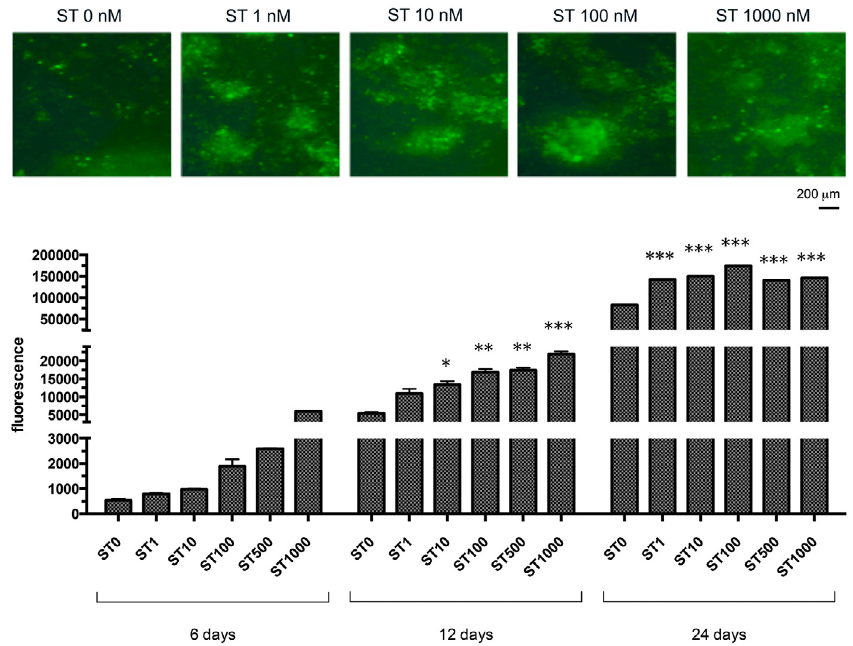
Figure 4- (a) Appearance of samples treated with stanozolol (ST) (0-1000 nM) at 24 days observation period using a phase contrast microscopy and fluorescence microscopy to reveal Calcein Green staining (10X magnification); (b) Graph illustrating fluorescence absorbance of Calcein Green staining with different ST concentrations (0-1000 nM) at 6, 12 and 24 days observation period. Data are expressed as mean ± standard deviation. Asterisks indicate statistical significance (*: p<0.05 vs ST 0 nM; ** p<0.005 vs ST 0 nM; ***: p<001 vs ST 0